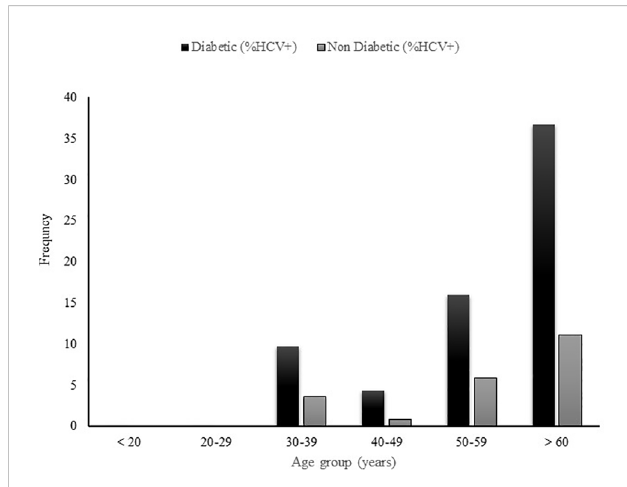
FIGURE 2 Prevalence of HCV infection in diabetic and non-diabetic patients by age